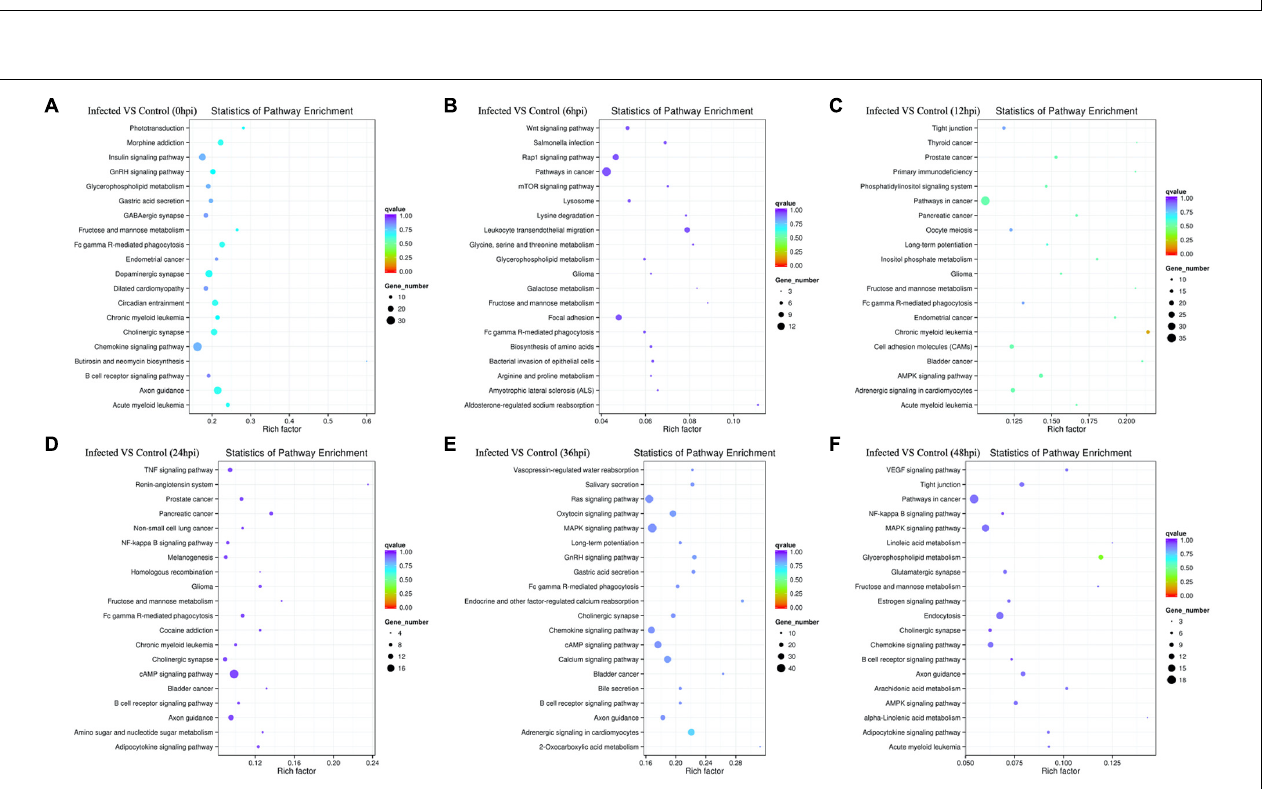
FIGURE 6 | (A–F) Rich distribution points of candidate target genes with Kyoto Encyclopedia of Genes and Genomes (KEGG) enrichment between the infected and control groups from 0 to 48 hpi. The vertical axis represents the pathway name, the horizontal axis represents the Rich factor, the size of the dots indicates the number of candidate target genes in this pathway, and the color of the dots corresponds to the different Q -value ranges.